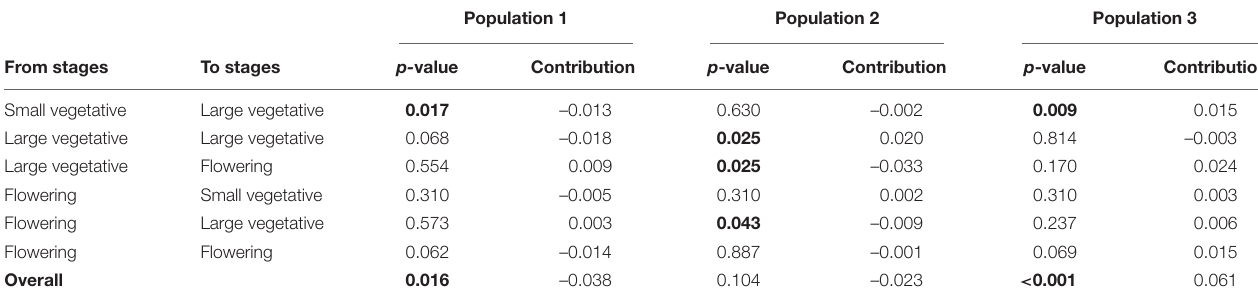
TABLE 2 | Results of LTRE analyses comparing the contribution of single matrix elements to the recorded variation in overall population growth rate between populations.